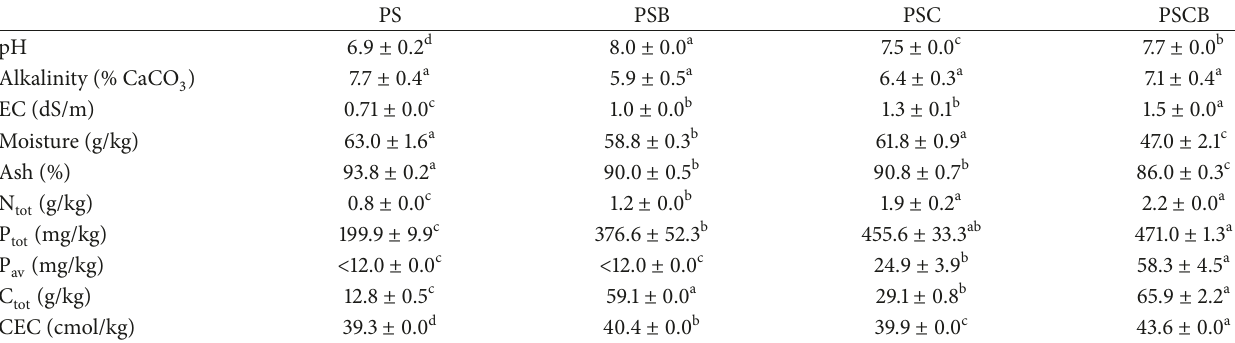
Table 2: Soil chemical properties . Data represent the mean ( 𝑛 = 4 ) ± standard error. Mean values marked with the same letter are not statistically different. One-way ANOVA was applied to weigh the effects of different treatments ( 𝑝 < 0.05 ).